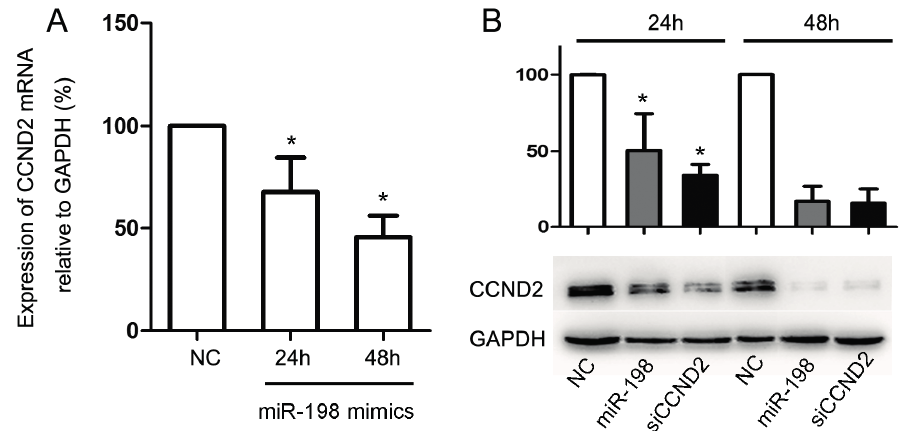
Figure 3. MiR-198 transfection repressed the mRNA and protein expression of